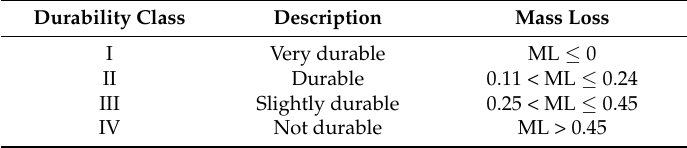
Table 1. Classification of the natural durability of wood to fungal attack based on GB/T 13942.1-2009